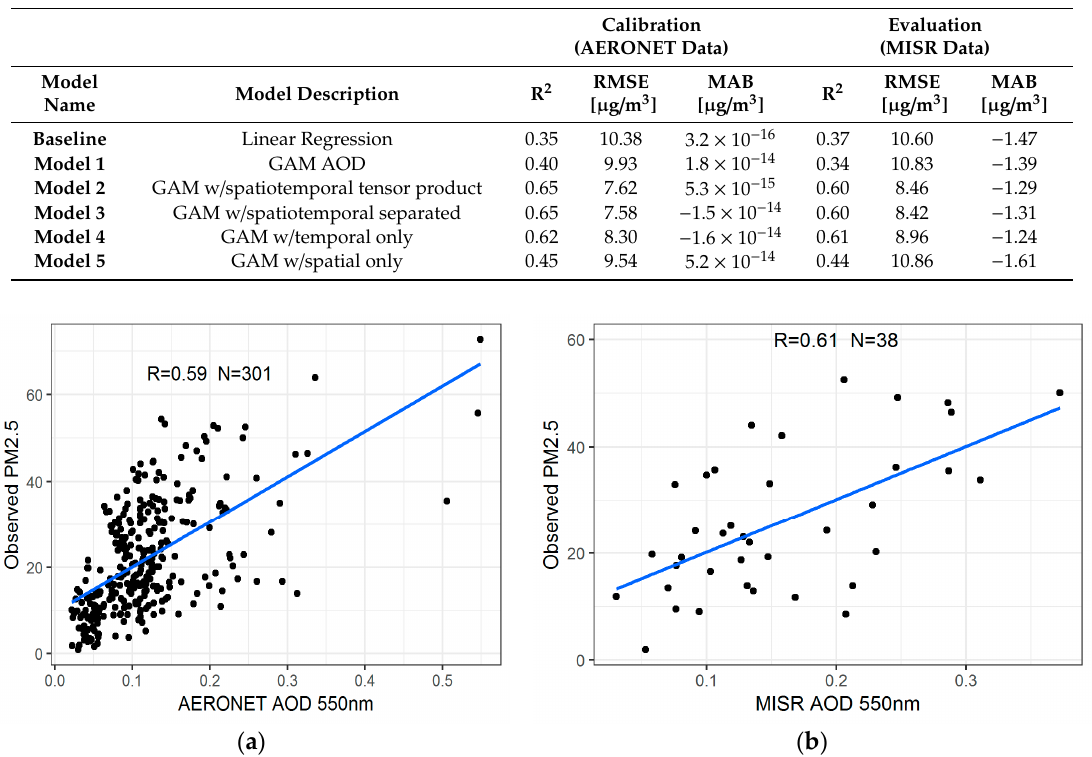
Figure 3. Linear regression (baseline model) between the observed daily PM 2.5 concentrations and ( a ) AERONET AOD 550 nm; ( b ) MISR AOD 550 nm. The blue line represents the regression line.